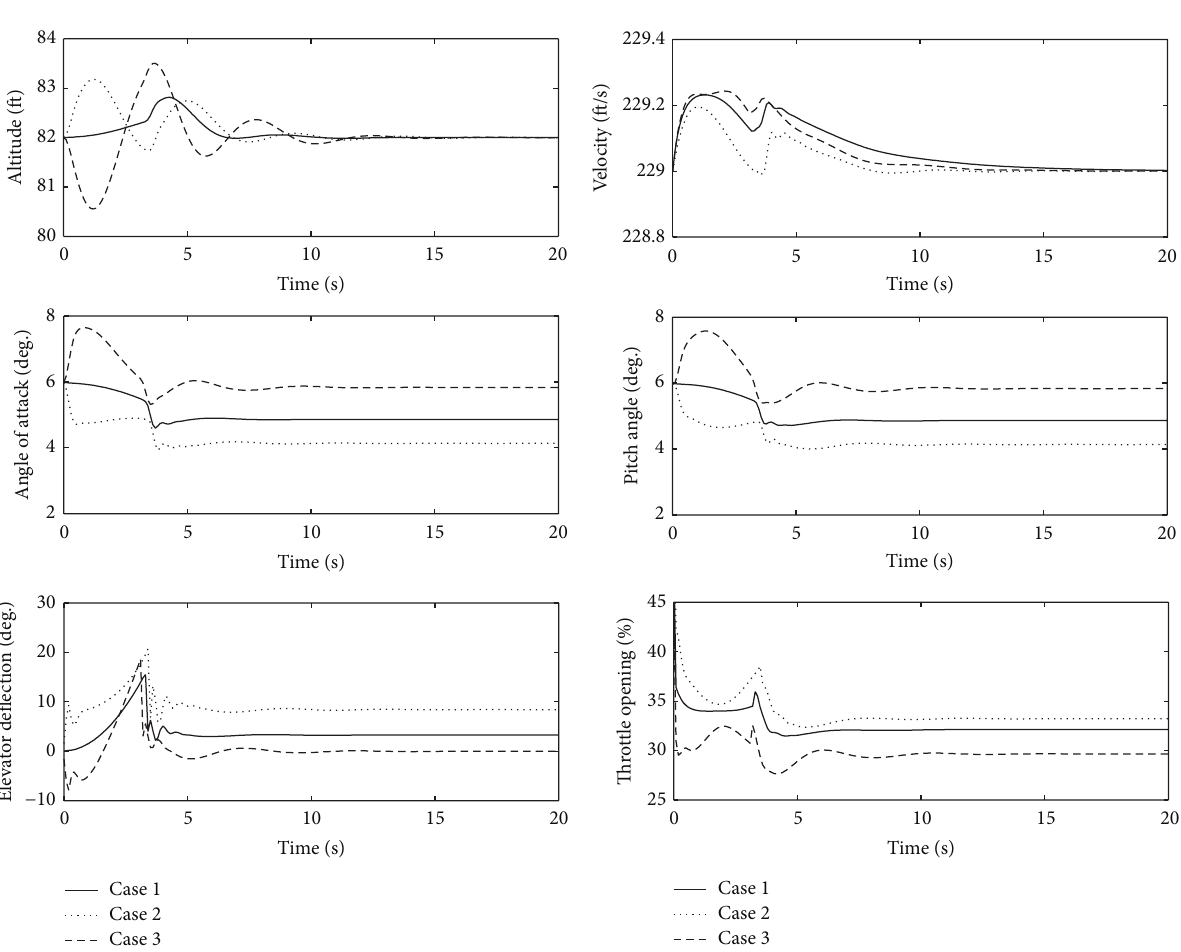
The compact sets can be conservatively set to 𝜙 = 0.3 , Θ